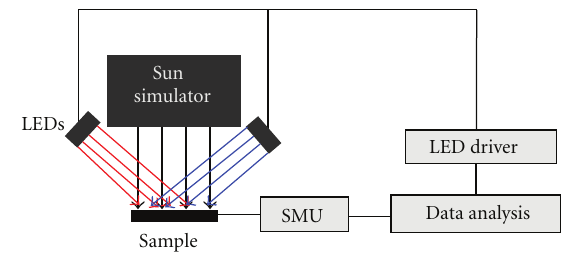
F 2: e experimental setup consists of a sun simulator that illuminates the solar cell. Additional illumination comes from two LED sources emitting at 450nm and ∼ F 1: Simulated current-power characteristics of the subcells (dash-dotted: top cell, dashed line: bottom cell) and of the com- bined hydrogenated amorphous/microcrystalline tandem solar cell (straight line). e output power is maximized to 11.6mWcm , corresponding to a gain of 2.6 when the −2 instead of 11.3mWcm currents of the subcells are power matched; that is, the currents −2 are matched at the maximum power point (black) instead of the % common current matching at zero voltage (gray). e total thickness of the simulated tandems was 1.5 m. 𝜇𝜇𝜇𝜇